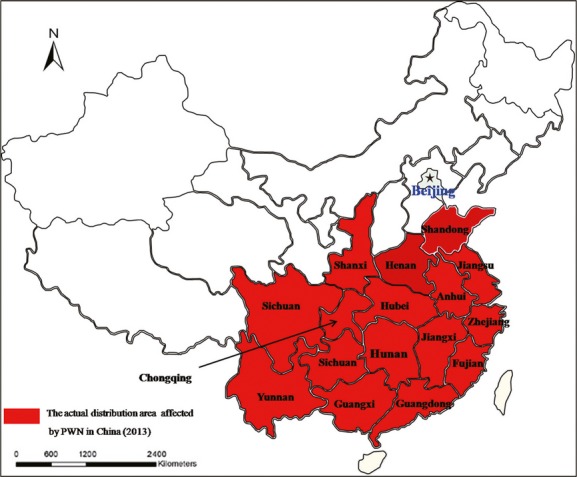
Current distribution of pine wilt disease throughout the southeastern provinces of China (2013). (Data obtained from the No.2 bulletin of State Forestry Administration in 2014—The epidemic area of Pine Wilt Disease. www.forestry.gov.cn/main/3600/content-657977.html).